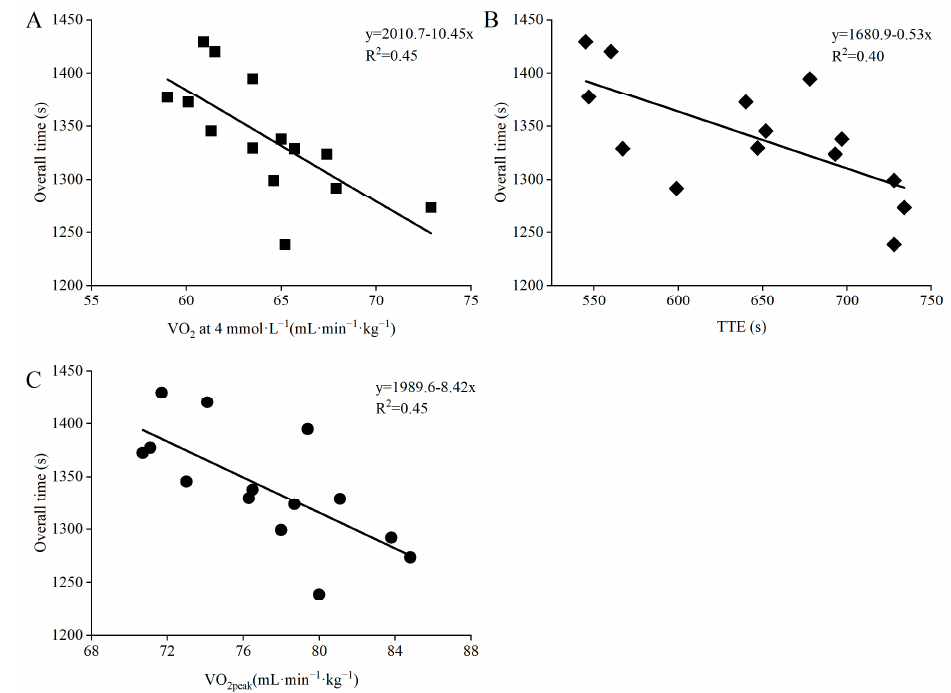
Figure 5. Relationship between 10 km skating time-trial performance and ( A ) oxygen uptake at of 4 mmol · L − 1 blood lactate, ( B ) peak oxygen uptake (VO 2peak ), and ( C ) time to exhaustion (TTE) in roller skating during laboratory testing in fourteen national-level male cross-country skiers. Presented with individual data points and trend lines based on linear regression.